Question: What form of chart is displayed?
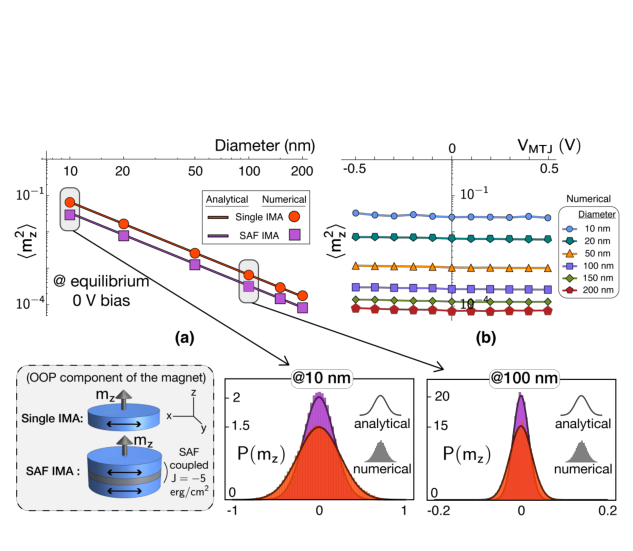
Answer: line